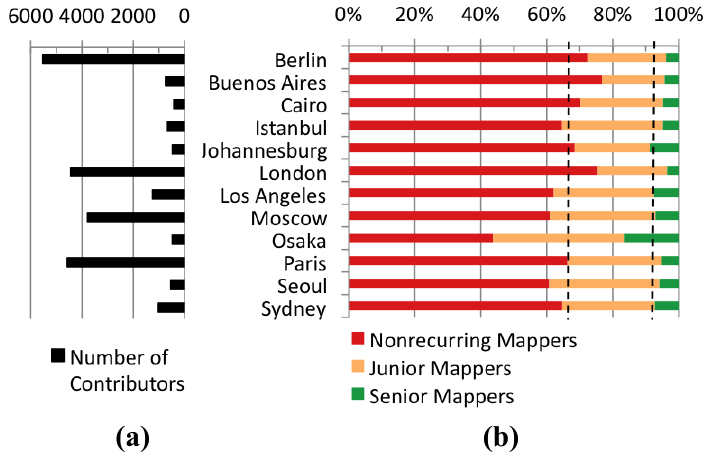
Figure 3. (a) Number of contributors; and (b) Distribution of mapper groups per urban area (Sept.